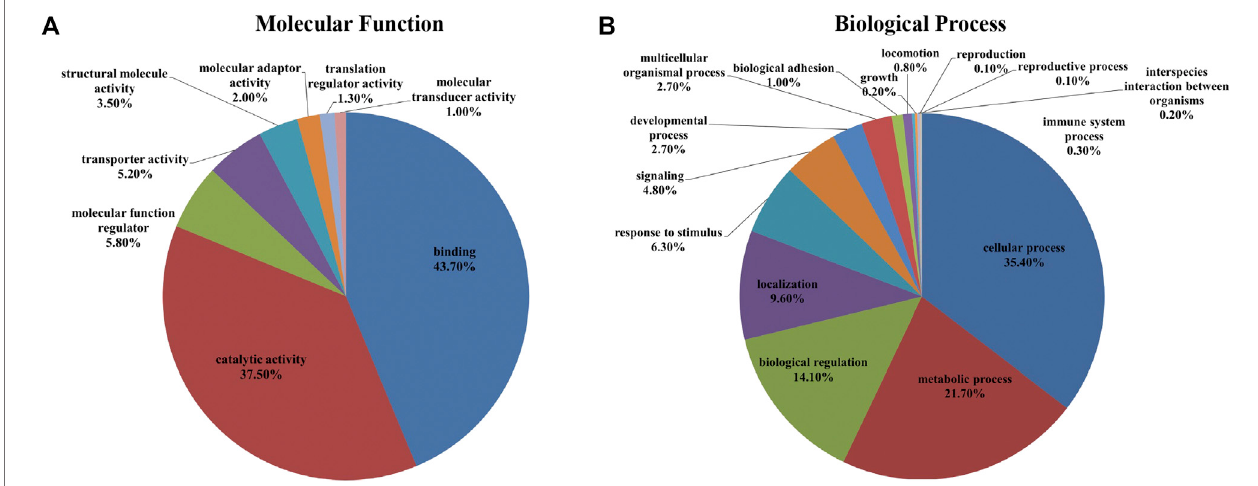
FIGURE5| Atotalof5,961identi fi edproteins (5,830genenames) wereannotatedwiththePANTHER ™ Classi fi cationSystem(www.pantherdb.org)accordingto their molecular function (A) and biological process (B) .